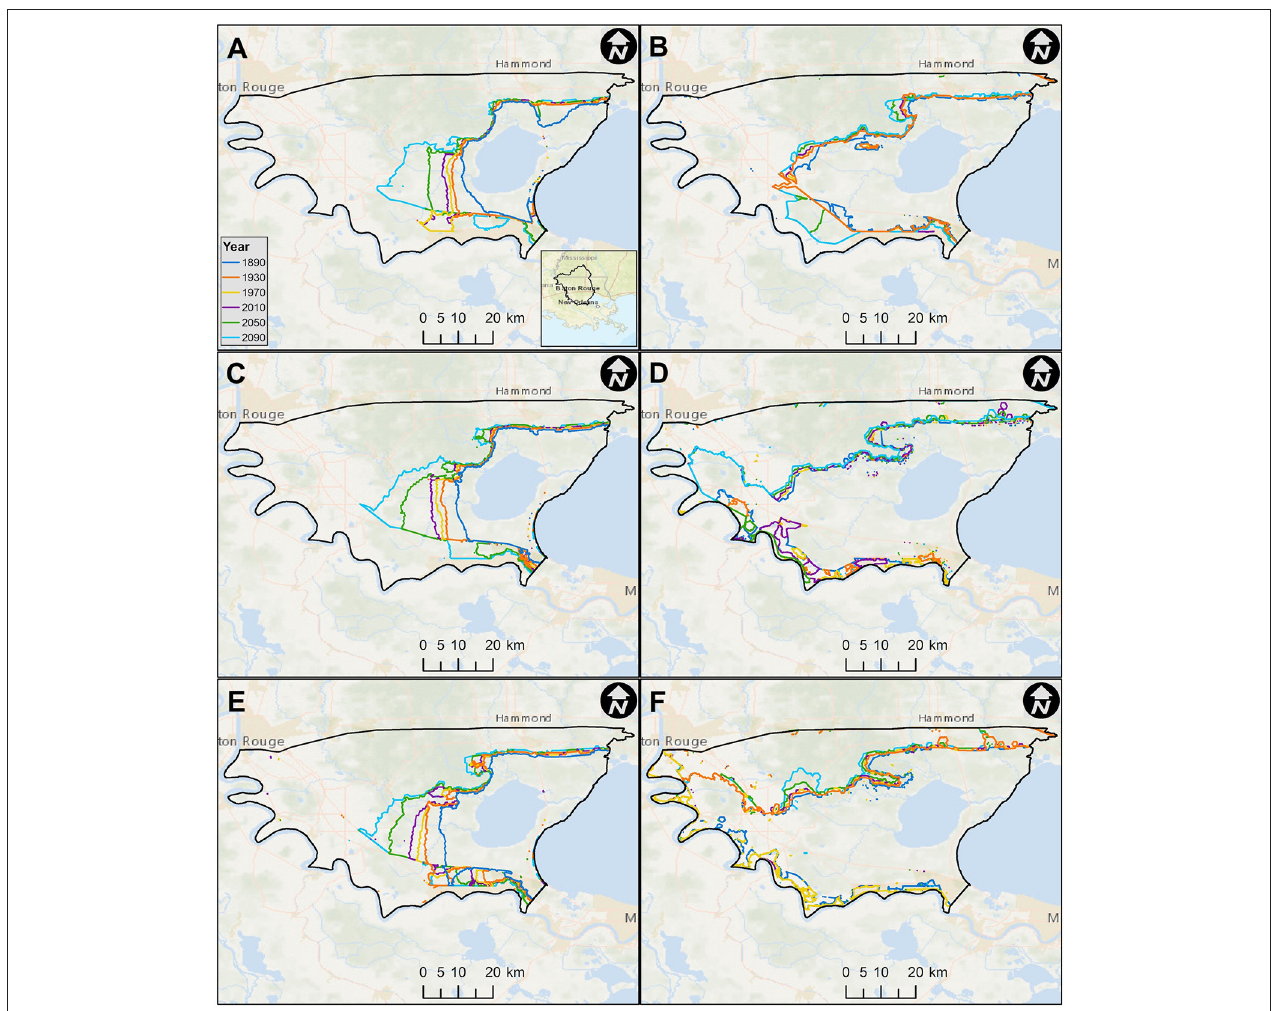
FIGURE 8 | Evolution of the (A,C,E) coastal and (B,D,F) hydrologic flood hazard zone extent for all years using the (A,B) low, (C,D) medium, and (E,F) high flood events at the Lake Maurepas watershed. Each color line represents a different era condition. Service Layer Credits: Esri, Garmin, GEBCO, NOAA NGDC, OpenStreetMap, and the GIS User